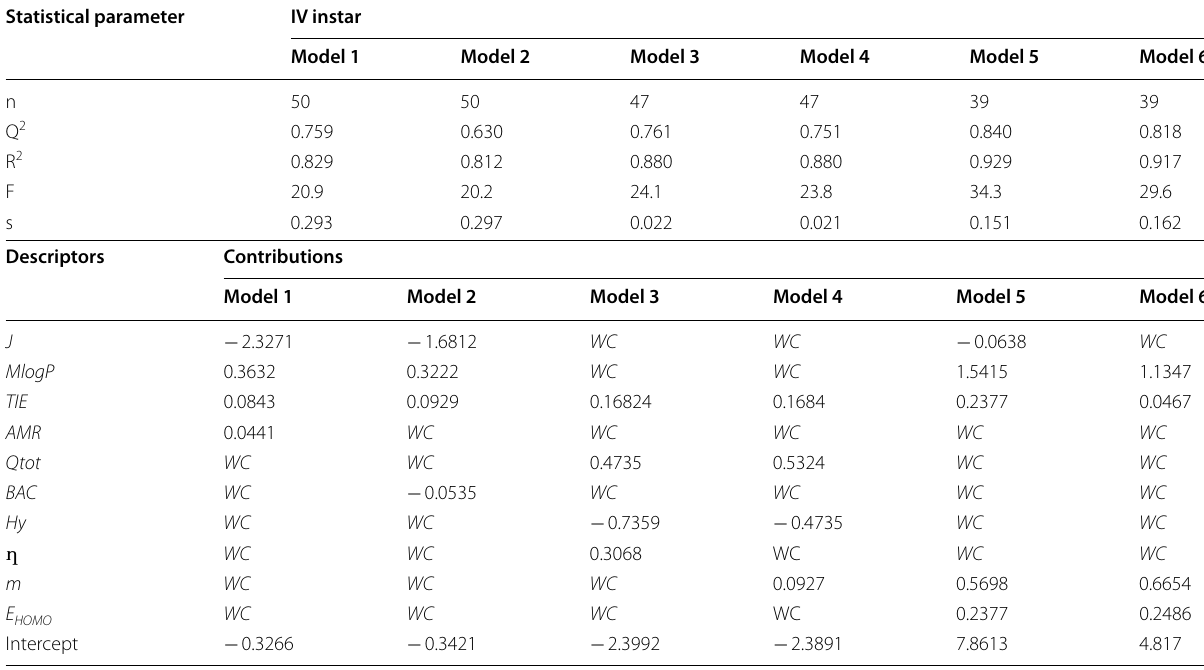
Table 4 Summary of the statistics quantitative property–larvicidal activity relationship models for activity against fourth instar of Cx.